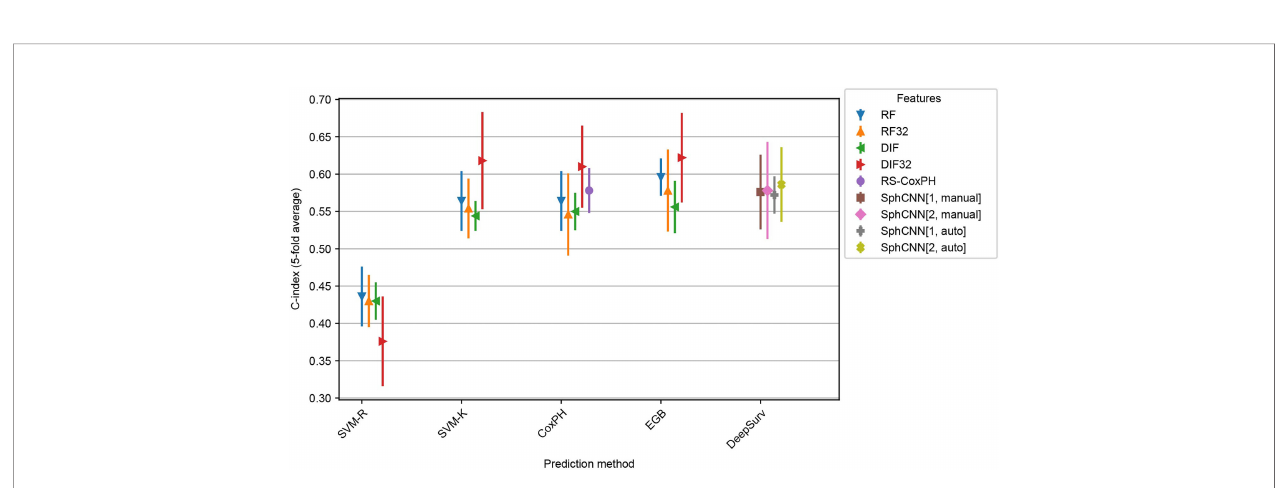
FIGURE 6 | Cross evaluation results for 17 baseline SRP methods and the proposed one. The models were trained on four splits from the Lung1 Data and evaluated on the remaining fi fth split. We report the average across the splits (marker) as well as the observed minimum and maximum observed values (line). Compared prediction methods are Support Vector Machines with regression (SVM-R) and ranging (SVM-K) objective, Cox Proportional Hazards model (CoxPH), Ensemble Gradient Boosting (EGB) and DeepSurv, a deep-learning-based prediction framework. Baseline features are Radiomics Features (RF) and pre-trained deep 2D Image Features (DIF). Both feature sets were also used with feature selection (RF32 and DIF32 respectively). In addition, we also include the Radiomics Signature (RS-CoxPH) suggested by Aerts et al. (2) in out comparison. Our proposed method uses a Spherical Convolutional Neural Network (SphCNN) with manual (SphCNN [ … , manual]) and automatic (SphCNN[ … , auto]) tumor segmentation. The spherical input for the SphCNN is either extracted via depth-image projection from the segmentaion mask (SphCNN[1, … ]) or composed of intensity projection and extended gaussian image from the CT-image (SphCNN[2, …